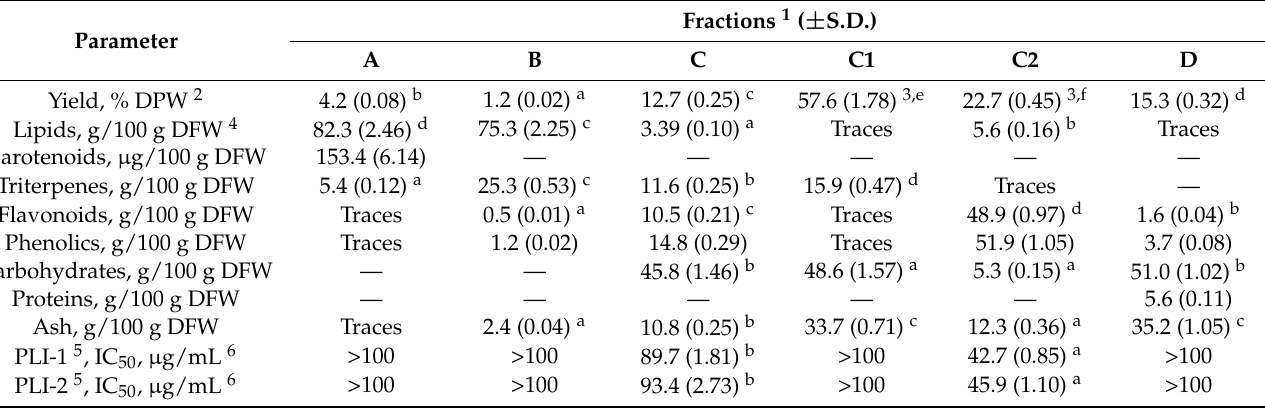
Table 2. Yield, composition, and mammal pancreatic lipase inhibition (PLI) of cucumber flower